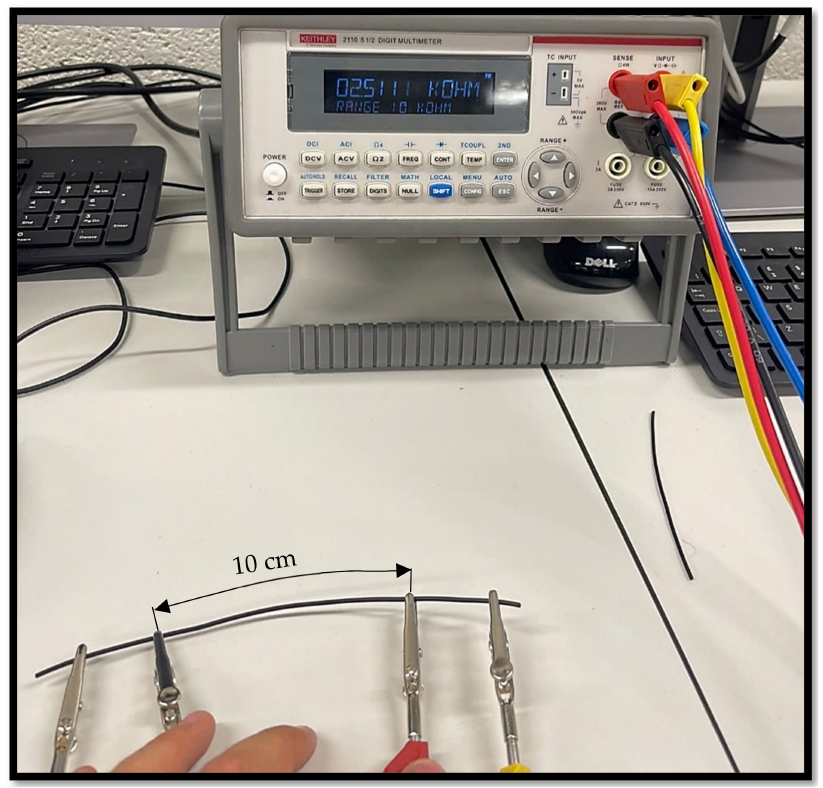
Figure 5. Typical 4-wire setup for filament’s electrical resistance measurements conducted on fila- ments and